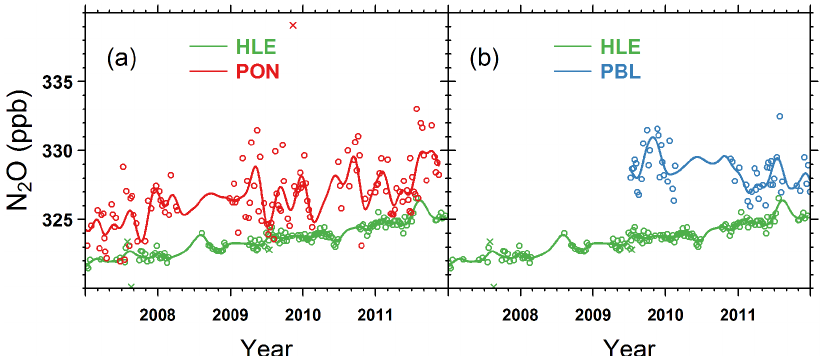
Figure 6. Time series of N 2 O flask measurements at (a) HLE and PON and (b) HLE and PBL. The open circles denote flask data used to fit the smoothed curves, while crosses denote discarded flask data lying outside 3 times the residual standard deviations from the smoothed curve fits. For each station, the smoothed curve is fitted using Thoning’s method (Thoning et al., 1989) after removing outliers.